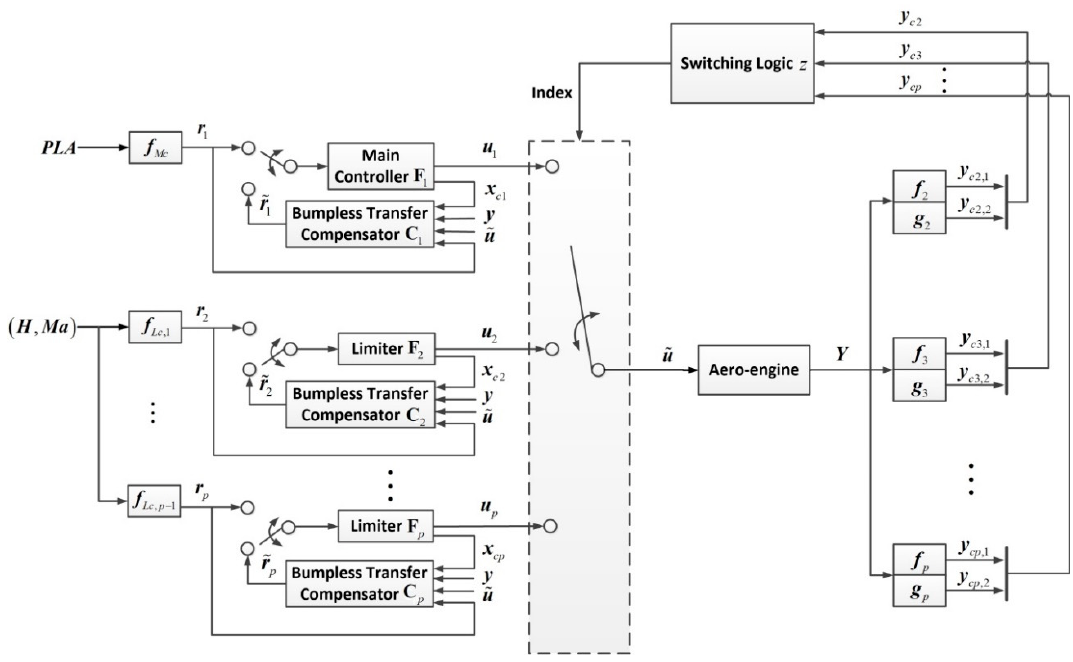
Figure 7. Schematic diagram of the output-based bumpless transfer limit management method for the aero-engines.